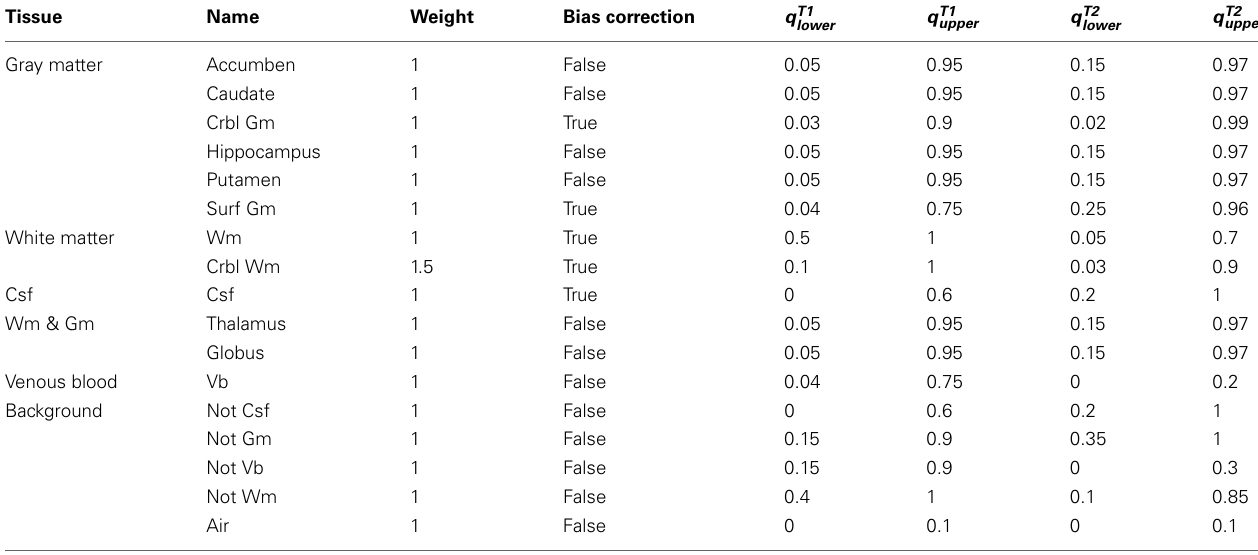
FIGURE 2 | 17 Spatial priors. (Denote gray [gr], green [gn], and red [r] ) . (A) Air [gr], accumben [gn], and cerebellum GM [r], (B) Not GM [gr], globus pallidus [gn], and CSF [r], (C) Not CSF [gr], hippocampus [gn], and cerebellum Table 1 | Atlas definition of 17 region-specific intensity-context prior.